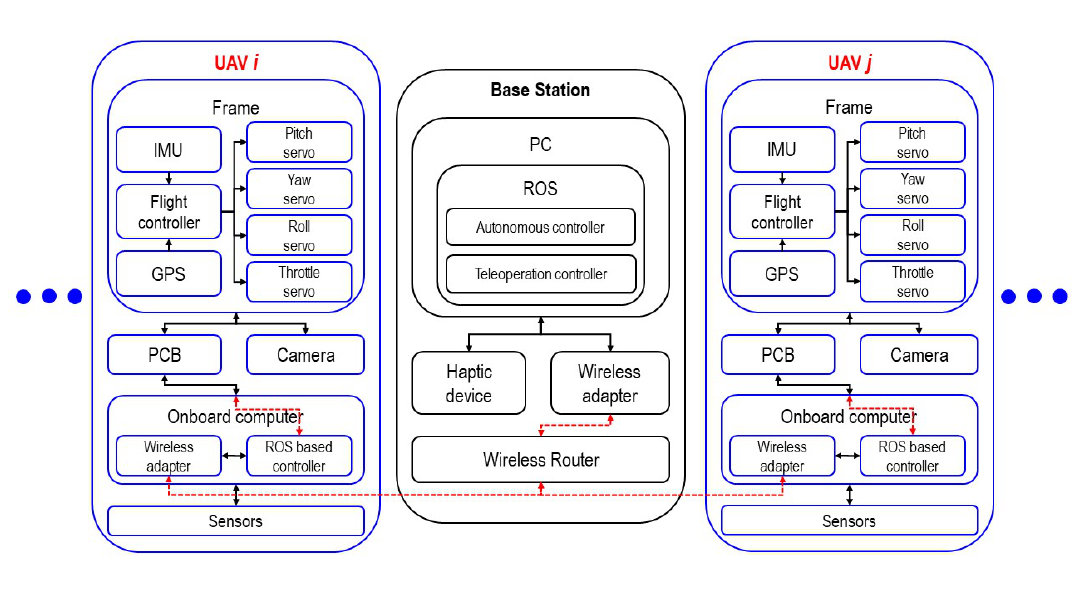
Figure 4. Scheme of multiple unmanned aerial vehicle (UAV) system: Robot operating system (ROS) based distributed system. For this, additional onboard computers were mounted on the UAV and wireless router was used for communications. In addition, the ROS based controller is mounted not only on the computer but also on the UAV.